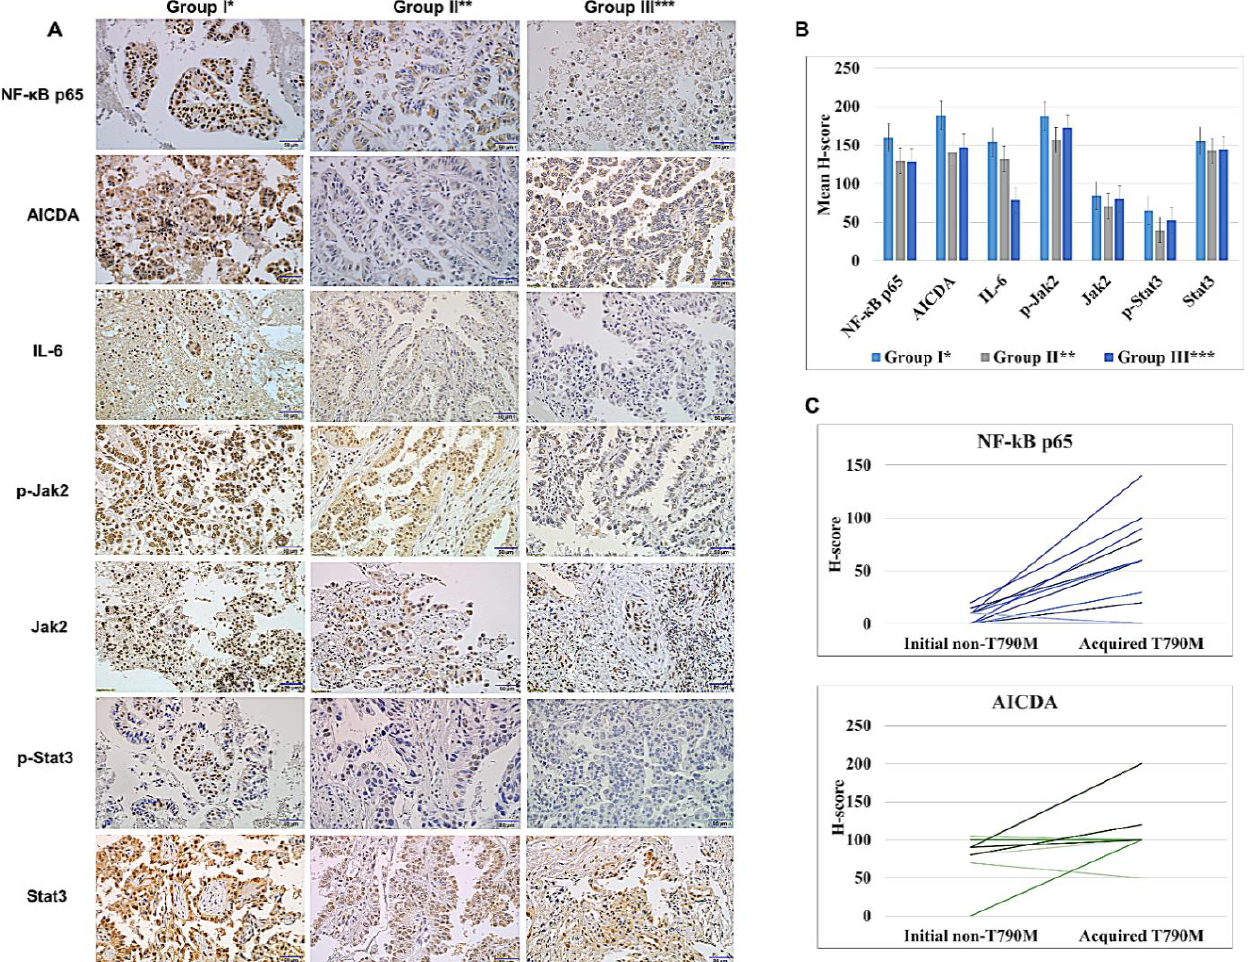
Figure 4. ( A ) Immunohistochemical results of the antibodies by patient groups (×400, scale bar: 50 µm). ( B ) Mean ± standard deviation of the immunologic H-scores by patient groups. ( C ) Matched analysis of NF- κB p65 and AICDA expression at baseline (initial non-T790M) and after acquired EGFR-TKI resistance ( n = 13). Group I*, EGFR-TKI-resistant LACs diagnosed with secondary site T790M EGFR mutation after TKI treatment; Group II**, EGFR-TKI-sensitive primary LACs with the non-T790M EGFR mutation; and Group III***, primary LACs with a T790M EGFR mutation prior to TKI treatment.